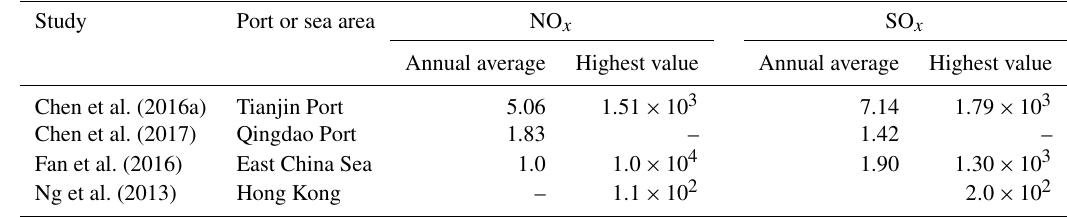
Table 3. Annual average and highest intensities of NO x and SO x (tyr − 1 km − 2 ) reported from research in the Asian region. Study